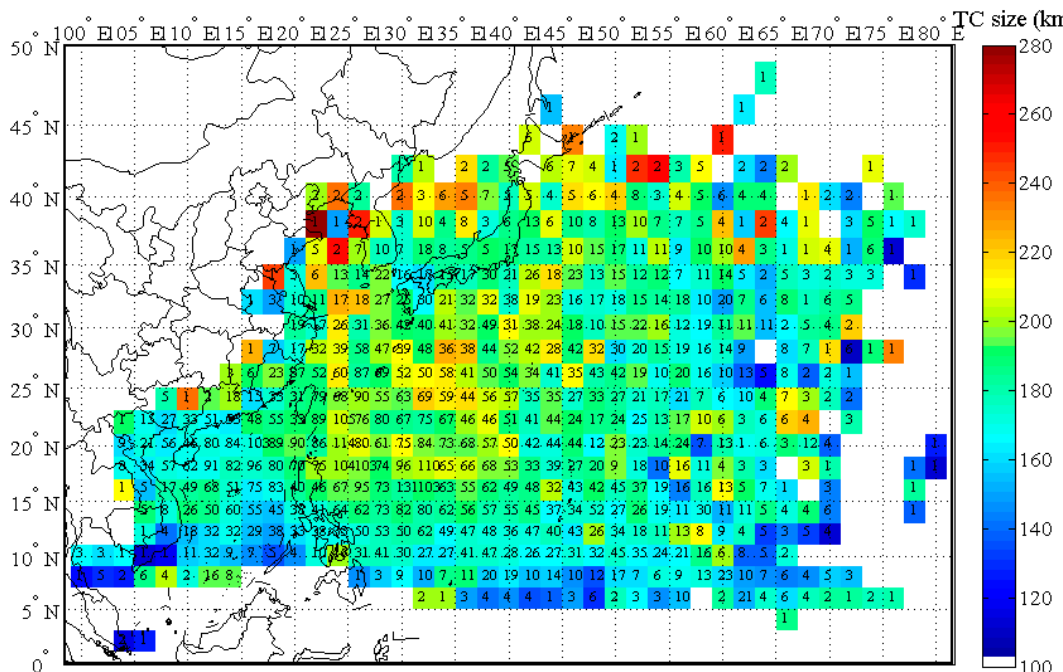
Figure 5. Regional distribution of the size of TCs (The grid size is 2 ◦ × 2 ◦ . The numbers in each grid square is the sample Figure5. Regional distribution of the size of TCs (The grid size is 2° × 2°. The numbers in each grid square is the sample size.)